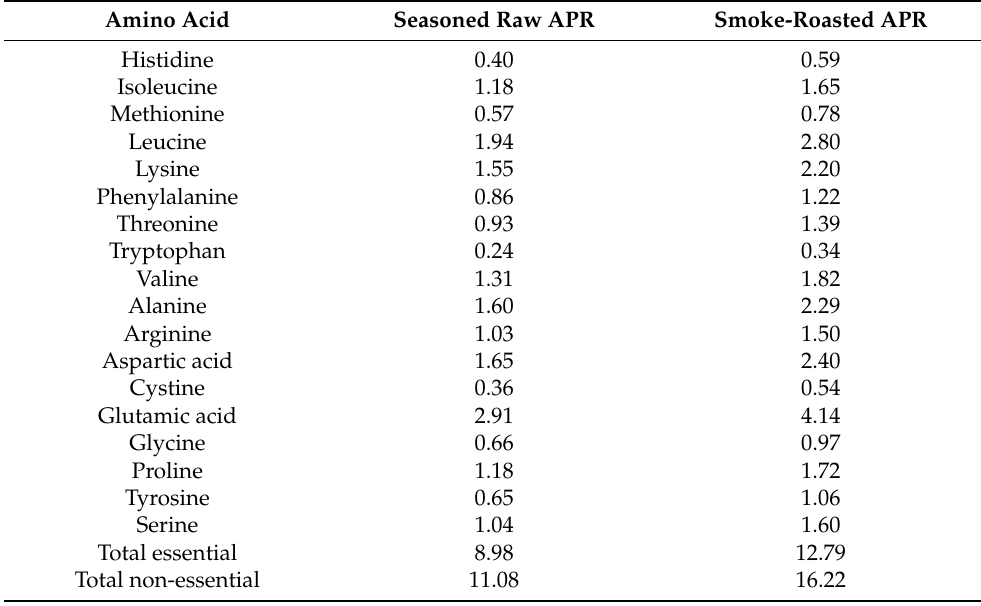
Table 6. Amino acid profile of seasoned raw and smoke-roasted Alaska pollack roe (APR) (g/100 g). Amino Acid Seasoned Raw APR